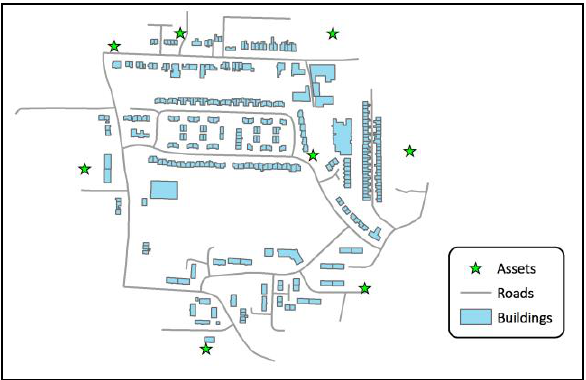
Figure 3. Input data set (Contains OS data © Crown copyright and database right 2018).